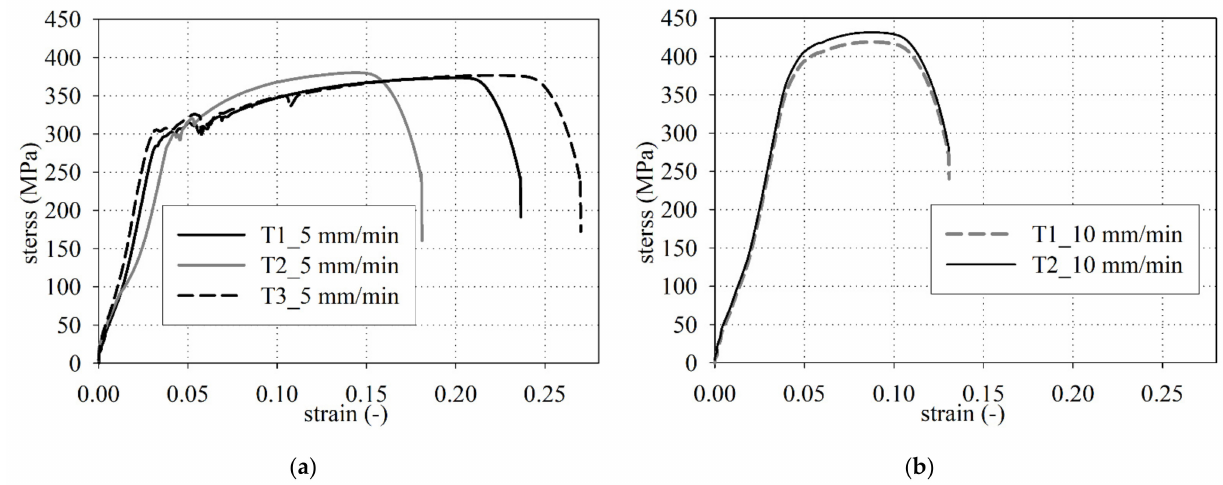
Figure 5. Stress–strain curves in tension: Test repeatability for two different displacement rates, 5 mm/s ( a ) and 10 mm/s ( b